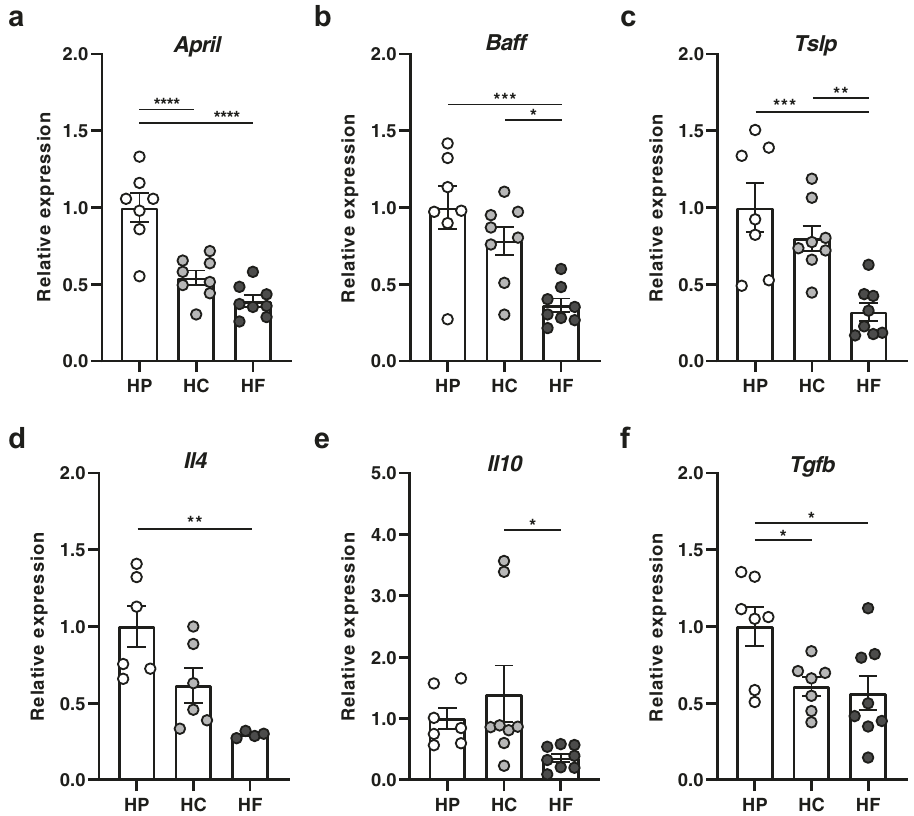
Fig. 3 High protein feeding promotes a pro-IgA cytokine environment, speci fi cally APRIL in the lamina propria. Mice were fed on either a high-protein (HP), high-carbohydrate (HC), or high-fat (HF) diet for 6 weeks and intestinal ileal gene expression of a April (HP vs. HC p = <0.0001, HP vs. HF p = <0.0001), b Baff (HP vs. HF p = 0.0005, HC vs. HF p = <0.0135), c Tslp (HP vs. HF p = 0.0005, HC vs. HF p = 0.0082), d Il4 (HP vs. HF p = 0.0033), e Il10 (HC vs. HF p = 0.0481) and f Tgfb (HP vs. HC p = 0.0481, HP vs. HF p = 0.0214) was determined by qPCR ( a – c , e n = 7 and n = 8 mice per diet for HP and HC/HF diet respectively, d n = 6 and n = 4 mice per diet for HP/HC and HF diet respectively, f ; n = 7 and n = 8 mice per diet for HP/HC and HF diet respectively). Data are represented as mean ± SEM. Results represent n = 2 independent experiments. * p < 0.05, **<0.01, ***<0.001, ****<0.0001 by ordinary one-way ANOVA followed by Tukey ’ s multiple comparisons